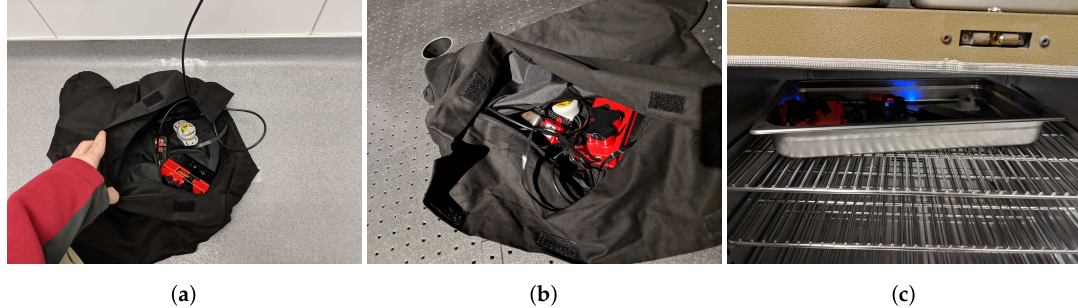
Figure 3. MicaSense RedEdge-3 and HOBO TidbiT MX Temp 400 during dark current testing in ( a ) cold room, ( b ) room temperature and ( c ) bench oven.